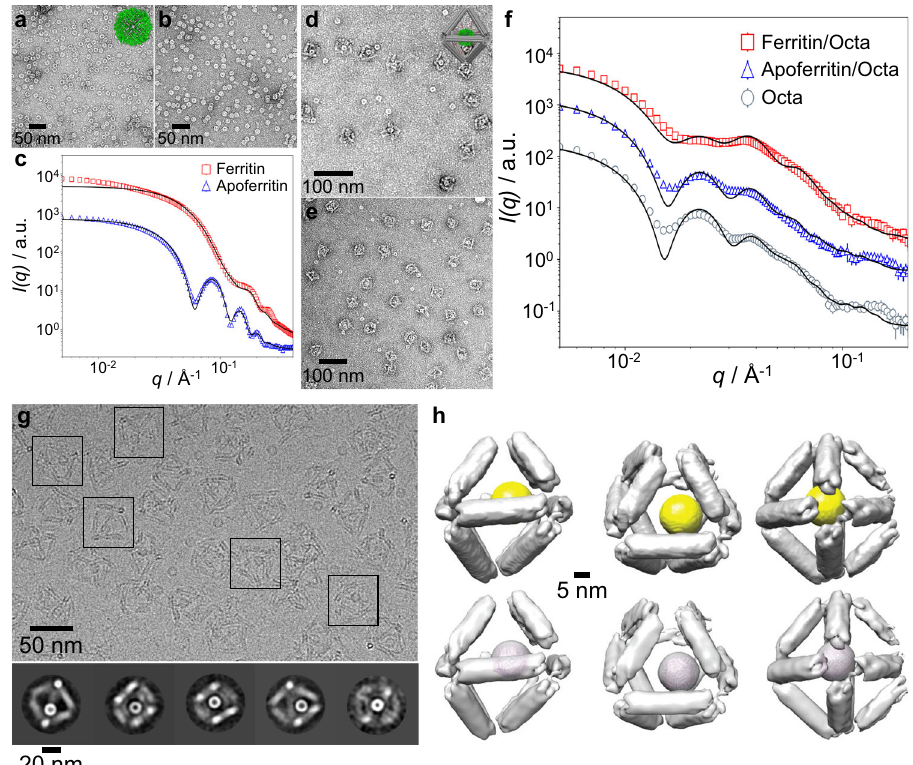
Fig. 2 Protein voxels: ferritin and apoferritin placed in the center (position Off0) of Octa frames, and characterized by in situ SAXS, ex situ TEM, and cryo-EM. a , b Negative-stained TEM imaging ( a ferritin, b apoferritin) and c SAXS measurement and analysis of free ferritin and apoferritin in solution (intensity pro fi les were shifted vertically for clarity). d , e Negative-stained TEM imaging ( d ferritin/Octa, e : apoferritin/Octa) and f SAXS data and analysis of ferritin and apoferritin encapsulated inside Octa (intensity pro fi les were shifted vertically for clarity). The insets in a and d show illustrated views of ferritin (PDB ID: 1IER) and ferritin/Octa. g Cryo-EM micrograph (top row) and 2D reference-free class average (bottom row) provided representative views of apoferritin/Octa. The black squares enclose the representative structures. h Surface-rendered 3D density maps of apoferritin/Octa, viewed from the two-fold (left), three-fold (middle), and four-fold (right) symmetry axes. In the bottom view, the apoferritin model (PDB ID: 2W0O) is docked in the density of